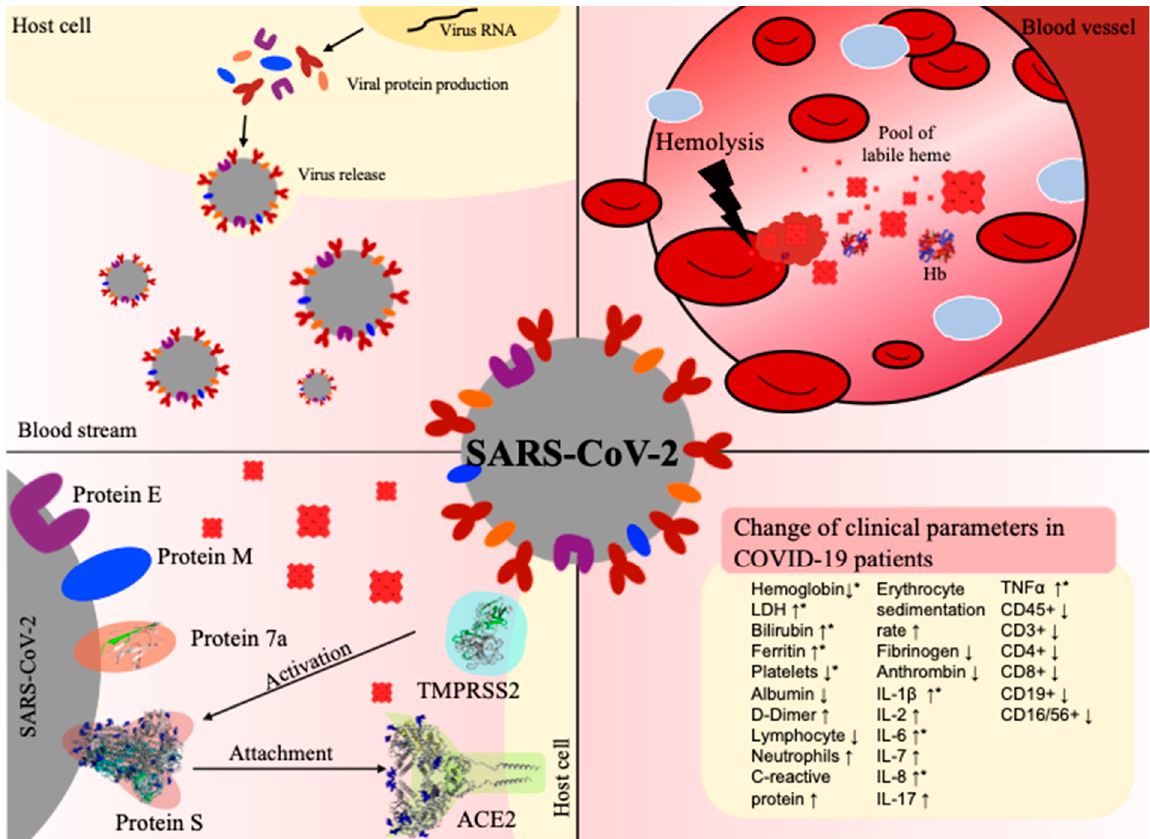
Figure 4. COVID-19 infection and hemolysis show common changes in clinical parameters. Top left: Virus (grey) release after conquering the host cell (yellow) and taking over its protein synthesis machinery. Top right: In the case of hemolysis, erythrocyte lysis occurs in a blood vessel, leading to degradation of hemoglobin (Hb) and, thus, to an excess of labile heme. Bottom left: Interaction between the virus and host cell before cell entry, involving in particular, the viral S protein and protein 7a as well as the human proteins TMPRSS2 and ACE2. Bottom right: Prominent changes in clinical parameters in patients suffering from COVID-19 infection ( ↑ increase, ↓ decrease). The terms depicted by an asterisk (*) have been reported in both hemolysis and COVID-19 infection [20,60]. PDBs: 1GZX (hemoglobin), 6VXX (S protein), 6M18 (ACE2), 6W37 (protein 7a).